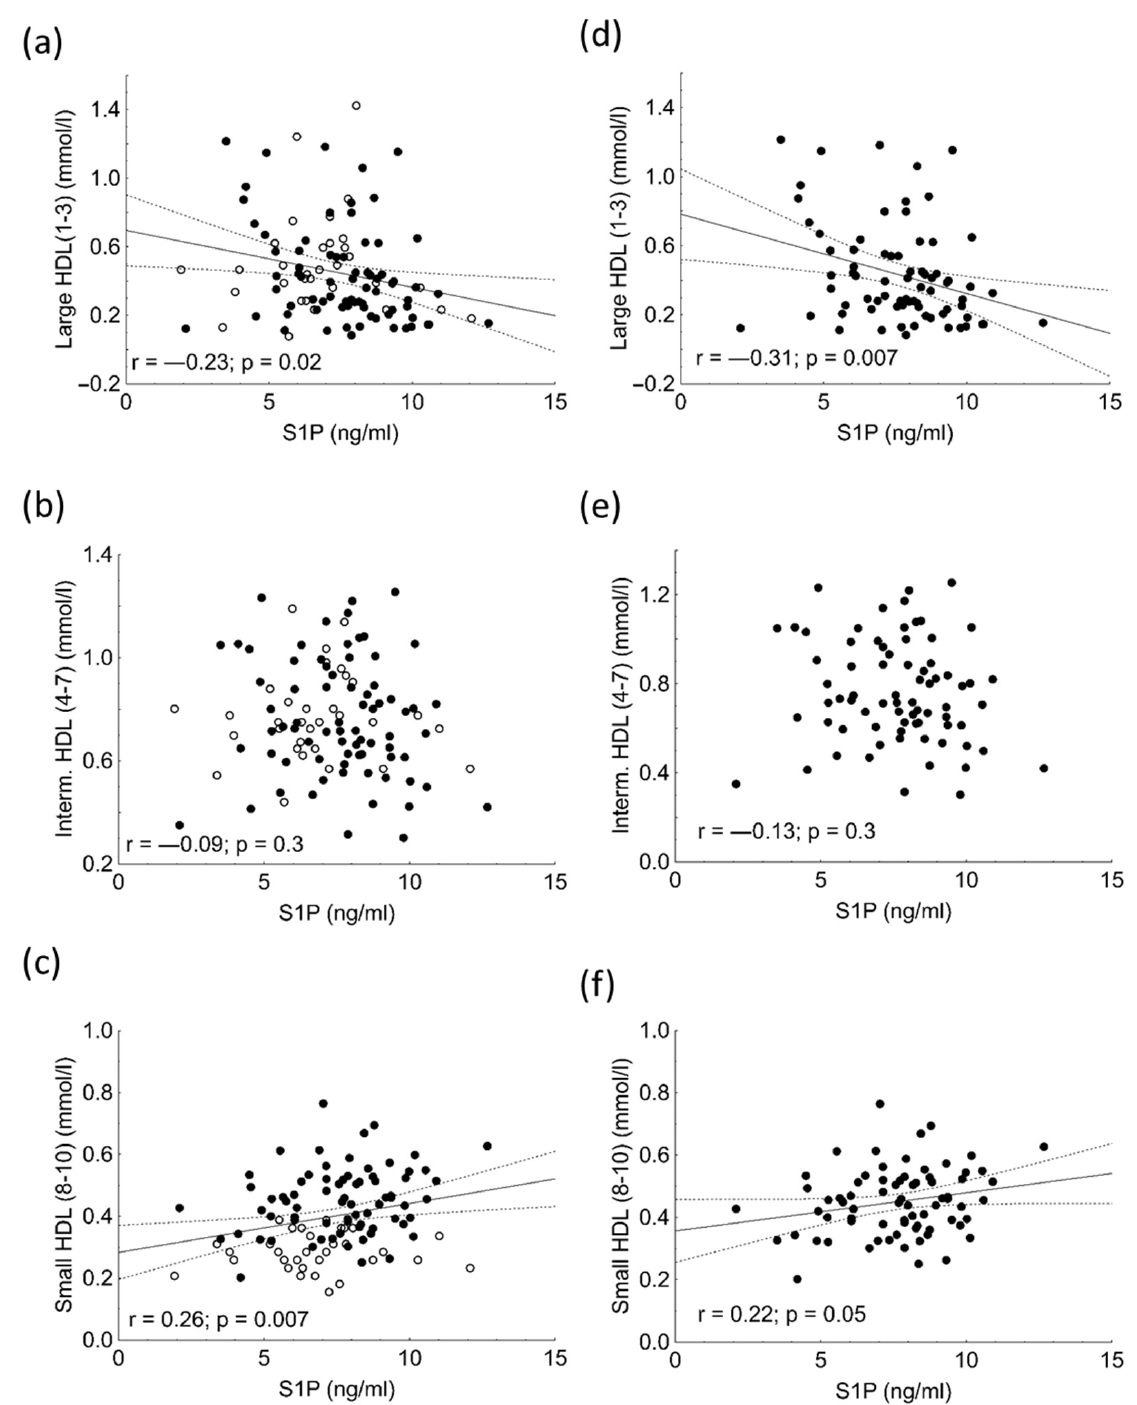
Figure 2. Correlations between the serum concentrations of large HDL subfraction and sphingosine 1-phosphate (S1P) in the in the whole study population ( a ) and in heterozygous familial hypercholesterolemic (HeFH) patients ( d ). Correlations between the serum concentrations of intermediate HDL subfraction and sphingosine 1-phosphate (S1P) in the in the whole study population ( b ) and in heterozygous familial hypercholesterolemic (HeFH) patients ( e ). Correlations between the serum levels of intermediate HDL subfraction and sphingosine 1-phosphate (S1P) in the whole study population ( c ) and in heterozygous familial hypercholesterolemic (HeFH) patients ( f ).